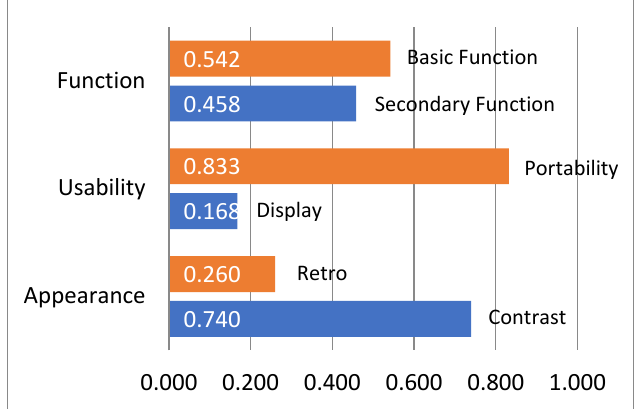
Figure 7. Optimized parameters of multiple linear superposition.